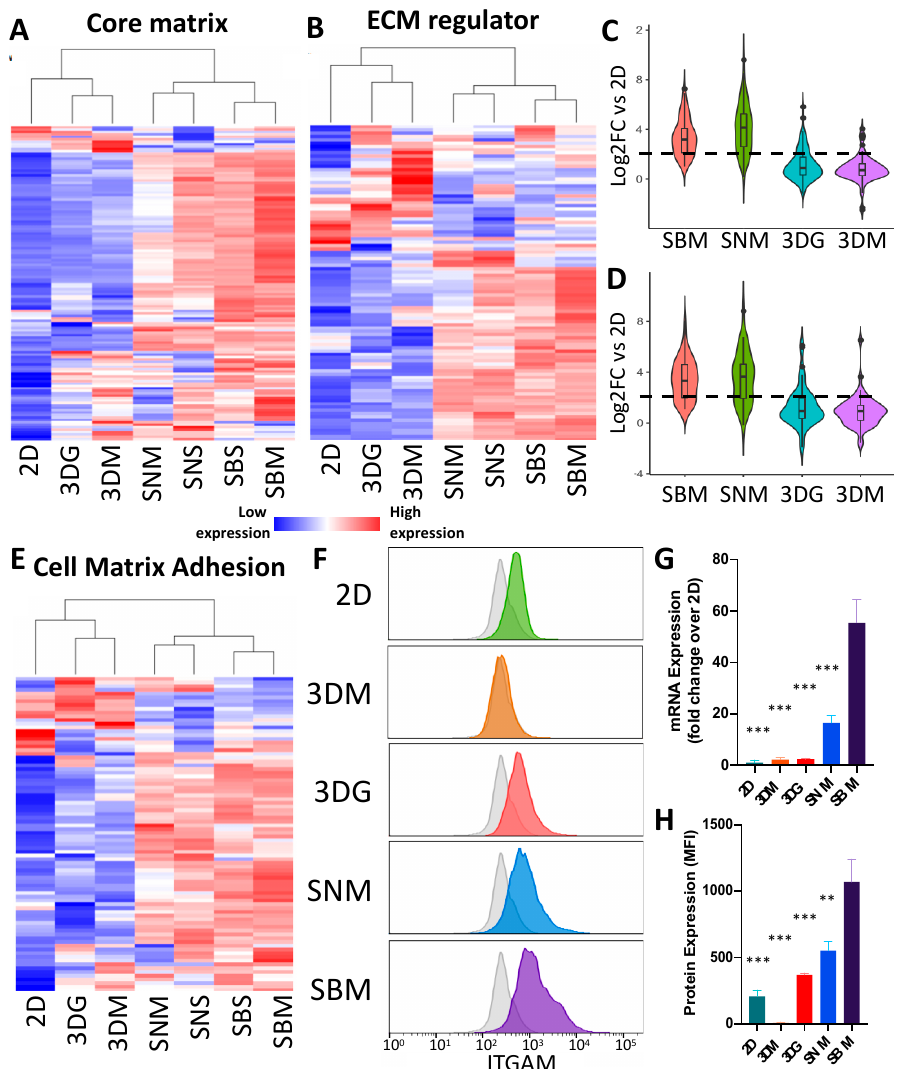
Figure 4. Extracellular matrix organization genes are up-regulated in cells cultured in 3D and in vivo conditions. Heat maps of di ff erentially core matrix genes ( A ) (Supplementary Table S5) and ECM regulator genes ( B ) (Supplementary Table S6) relative to 2D culture. Expression values represented are an average of 4–5 replicates. Violin plots depicting magnitude of up-regulation and distribution of SBM vs. 2D up-regulated corematrix genes ( C ) andECM regulatorgenes ( D ) across other culturing conditions relative to 2D culture. Violin plot depicting magnitude of up-regulation and distribution of SBM vs. 2D up-regulated core matrix genes across other culturing conditions relative to 2D culture. ( E ) Heat map of di ff erentially expressed cell matrix adhesion genes (Supplementary Table S7) relative to 2D culture (n = 4–5). ( F ) Histogram of representative Itgam abundance of single cancer cells cultured in di ff erent methods. Grey shaded plots represent unstained controls. ( G ) mRNA expression levels of Itgam in 4T1 cells under di ff ering culturing condition. Expression levels normalized to 2D culture ± SEM. (n = 4–5). ( H ) Bar graph of flow cytometric analysis of ITGAM protein expression showing up-regulation in 3DG and in vivo conditions. Protein expression values represent background (unstained control) subtracted median fluorescent intensity of cancer cells ± SEM; (n = 4). (** p value < 0.001; *** p value < 0.0001 relative to